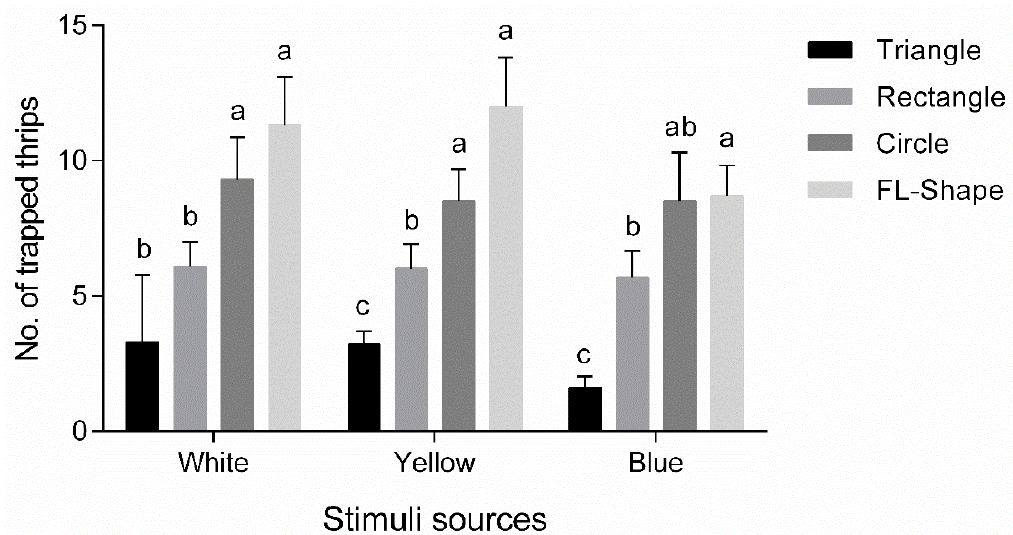
Figure 5. Preference of western flower thrips, Frankliniella occidentalis to triangle, rectangle, circle and flower shape. FL ‐ Shape: flower shape. Different lowercase letters indicate significances between different shapes (Tukey’s HSD test, p < 0.05).